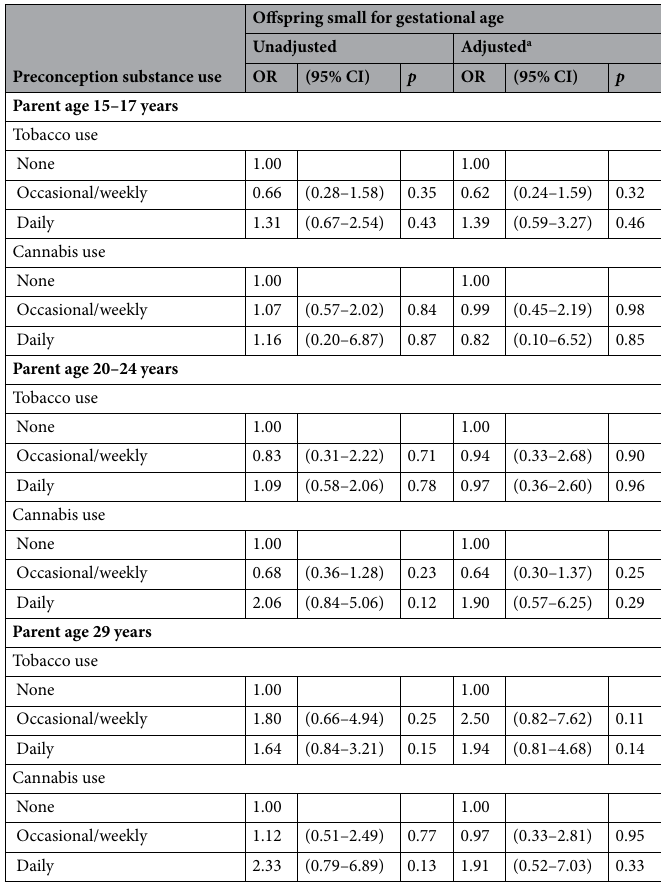
Table 4. Logistic regression analysis of relationship between tobacco/cannabis use frequency at age 15–17, 20–24 and 29, and small for gestational age in 1030 children born to 665 parents (OR = odds ratio, CI = confidence interval). a All adjusted models adjusted for baseline/adolescent covariates: parent sex, offspring sex, family SES, grandparent education level, grandparent smoking status, adolescent mental health, and concurrent use of cannabis for models where tobacco is the exposure and vice versa. Adjusted models at age 20–24 years also include adjustment for frequency of use of the substance at age 15–17 years. Adjusted models at age 29 years models also include adjustment for frequency of use of the substance at age 15–17 and age 20–24